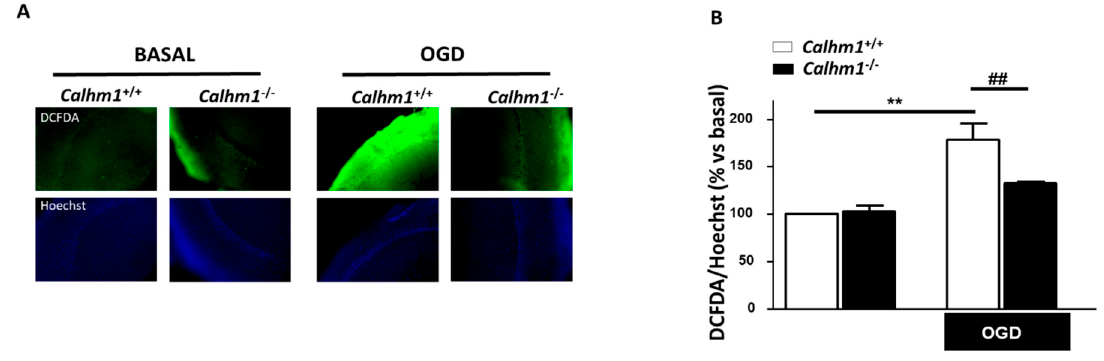
Figure 4. ROS production is attenuated in Calhm1 − / − hippocampal slices upon OGD / Reox. ( A ) Images on the top show DCFDA fluorescence for ROS production and images on the bottom show Hoechst fluorescence as an indicator of nuclei density in the CA1 region of hippocampal slices from Calhm1 +/+ and Calhm1 − / − mice, under basal or after OGD / Reox exposure. ( B ) Quantitative analysis of ROS production is indicated as the ratio of DCFDA / Hoechst fluorescence intensity. Bars represent the means ± S.E.M of three di ff erent animals from each group; all variables were performed in parallel. ** p < 0.01 versus basal Calhm1 +/+ ; ## p < 0.01 compared to OGD Calhm1 +/+ . One-way ANOVA followed by Newman-Keuls was made. Data were normalized to Calhm1 +/+ , which was considered as 100% of